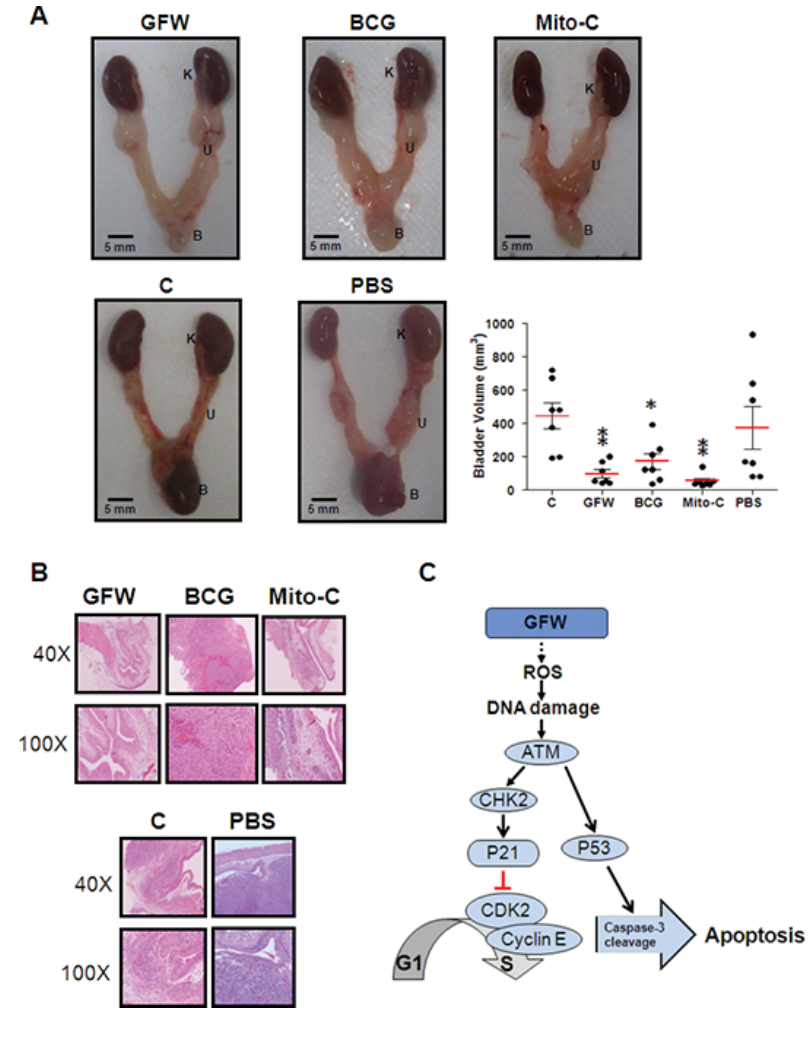
Figure 6. Effect of intravesical therapy in murine orthotopic bladder tumor model. (A) Female C57BL/6 mice aged 6 wks with tumor implantation were untreated (C) or treated with GFW, BCG, Mito-C or PBS according to the time schedule in Figure 1. After the mice were sacrificed, the urinary system was isolated and photographed. K, U and B indicate the kidney, urethra and bladder, respectively. The bladder volume was calculated by (length × width 2 )/2. Data are presented as mean ± SEM (n = 7). Significant differences from the control are indicated by * p < 0.05, ** p < 0.01, as determined by one-way ANOVA and Dunnett comparison test. (B) After the treatment cycle, the mice were sacrificed and bladder sections were stained with H&E for histopathologic